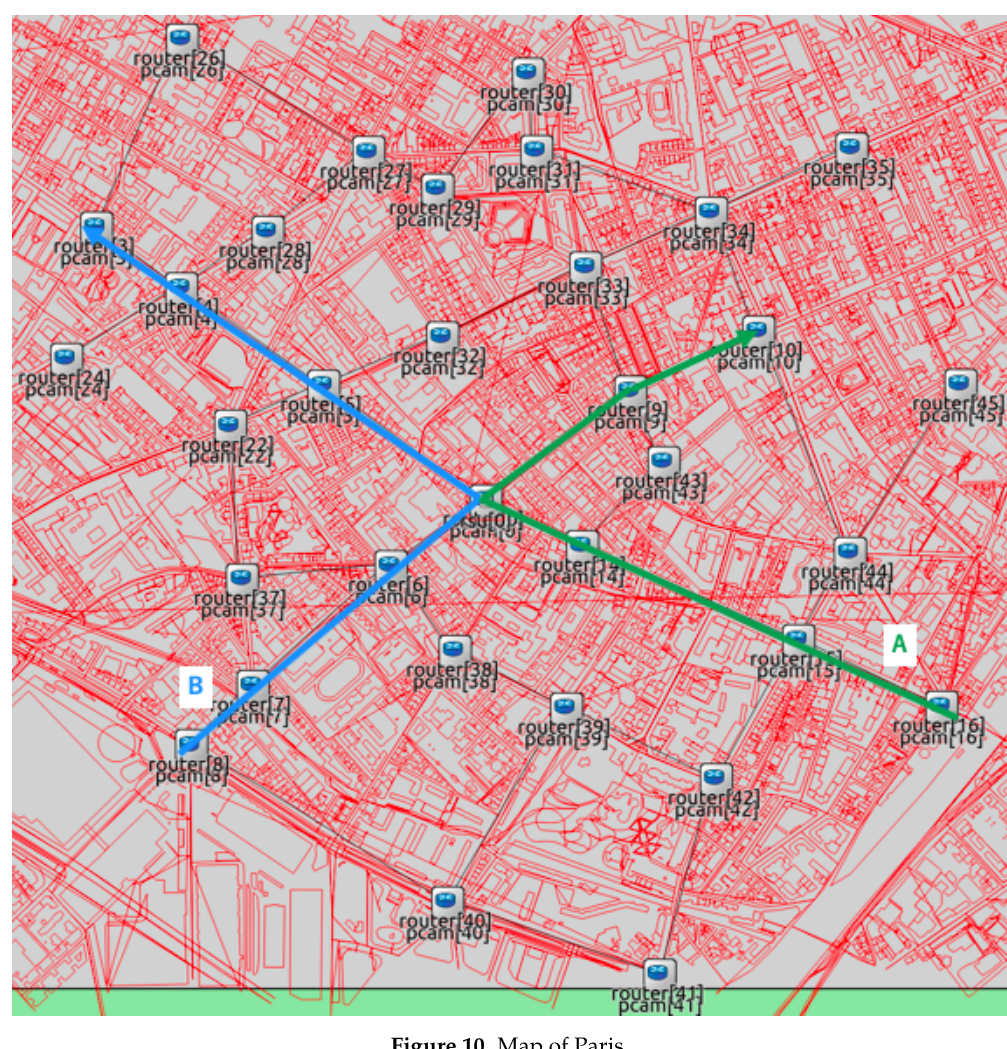
Figure 10. Map of Paris. Table 2. Parameters of